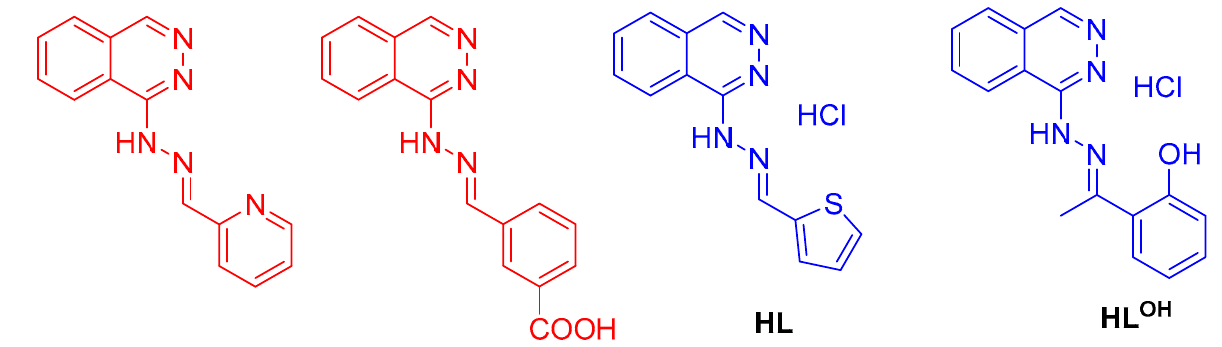
Figure 1. Structure of the studied hydralazine-based ligands; red color: previously reported ligand [15,57]; blue color: new ligands.